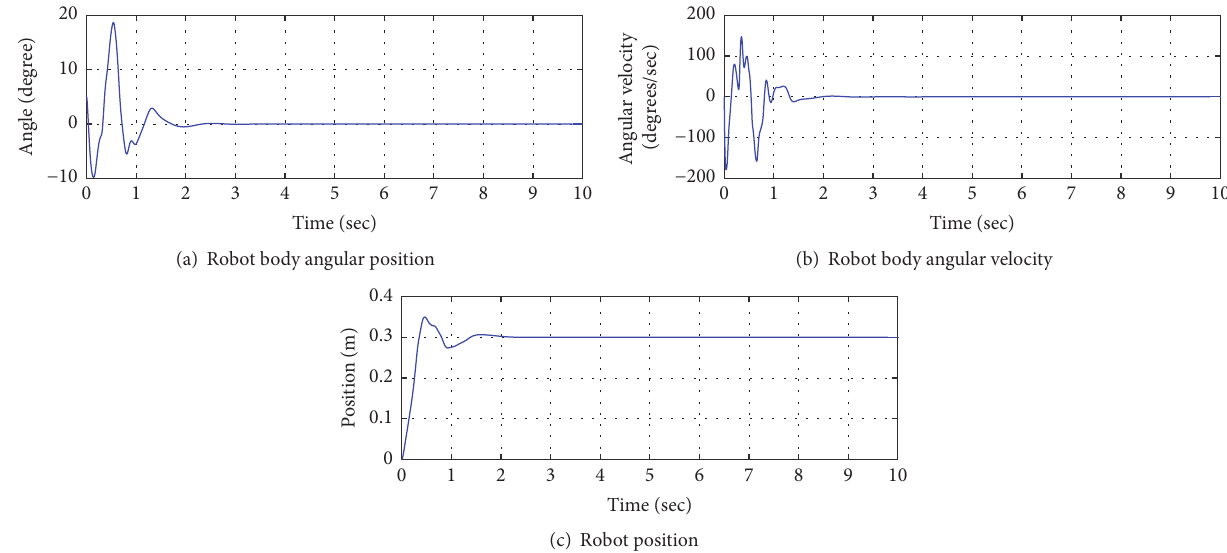
́𝜃 = 0 , and the referenced input 𝑥 𝑑 = 0.3 m.